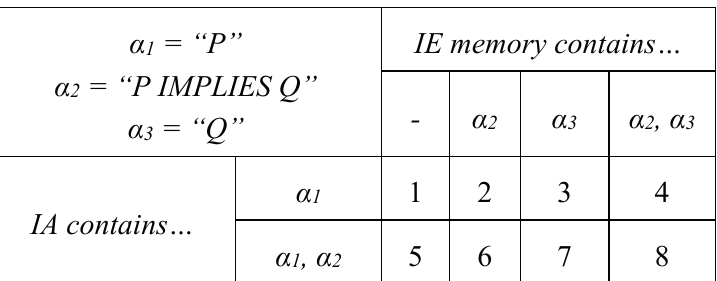
Table 4. Options for the amount of